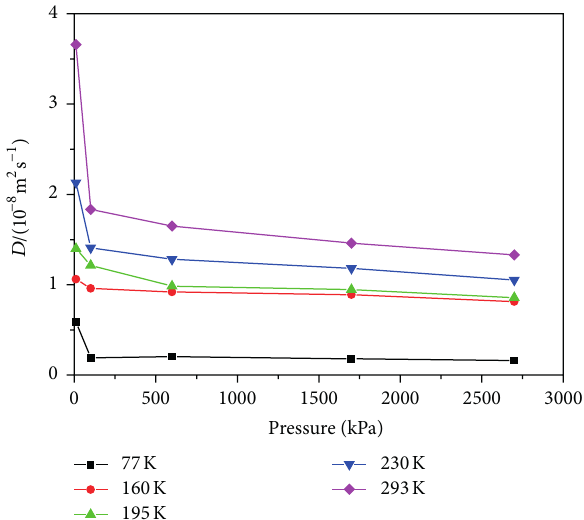
Figure 4: The self-diffusion coefficients of hydrogen at different temperatures.